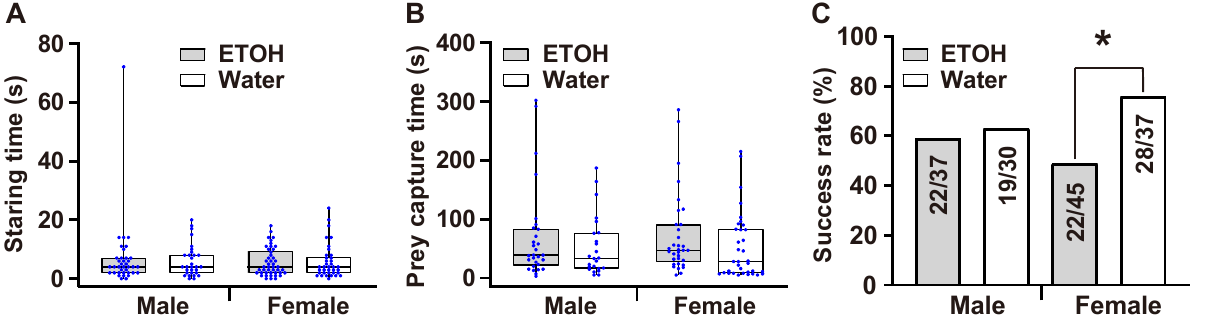
Figure 4. Prey capture efficiency of Myrmarachne gisti for males and females separately, showing ( A ) the time spiders spent staring at prey, ( B ) the time taken to capture prey, and ( C ) the success rate of their first attack. Boxplots show the data as jittered dots, with the box indicating the interquartile range (IQR), the whiskers showing the range of values that are within 1.5 × IQR, and a horizontal line indicating the median. ‘ * ’ indicates a significant difference ( p < 0.05).